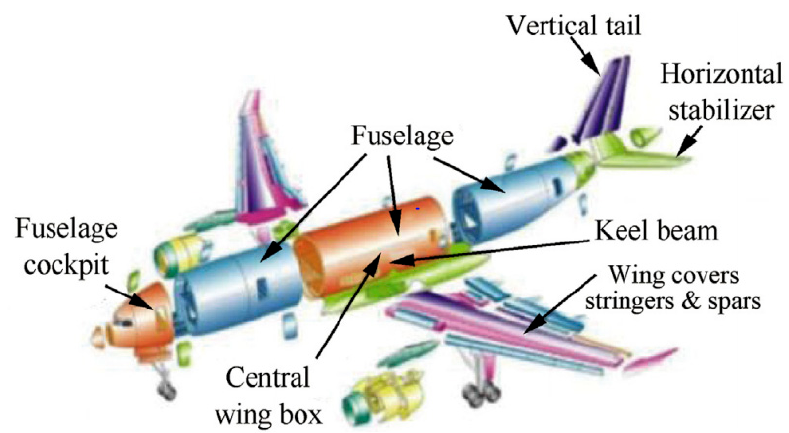
Figure 9. CFRP composite applications in various components of an Airbus 350 (source: Hexcel [93]).